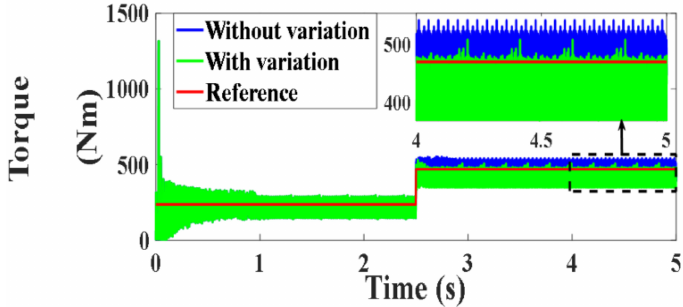
Figure 135. Developed torque under PVC